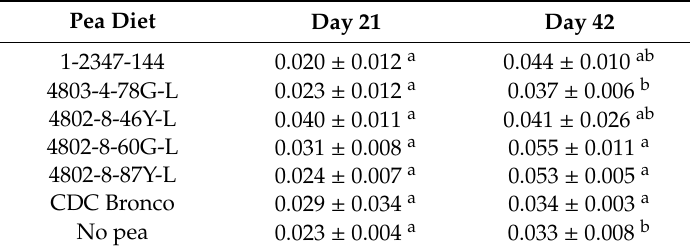
Table 11. Pectoral muscle glycogen concentrations (AU) 1 .